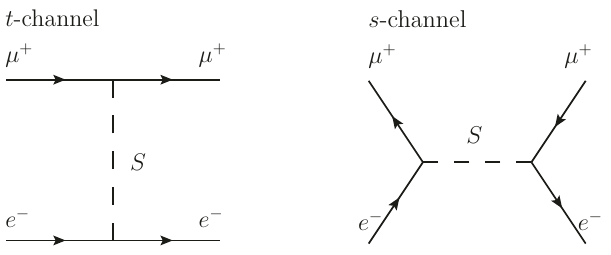
Figure 10 . Feynman diagrams of (cid:22) { e scattering mediated by a (cid:13)avor-conserving S in the t -channel (left) or a (cid:13)avor-changing S in the s -channel (right). light neutral scalar in the s -channel with (cid:13)avor-violating couplings y e(cid:22) . The corresponding Feynman diagrams are shown in (cid:12)gure 10. For simplicity we assume the light neutral scalar in both cases S(i) and S(ii) to be hadrophobic, i.e. with couplings to quarks and the